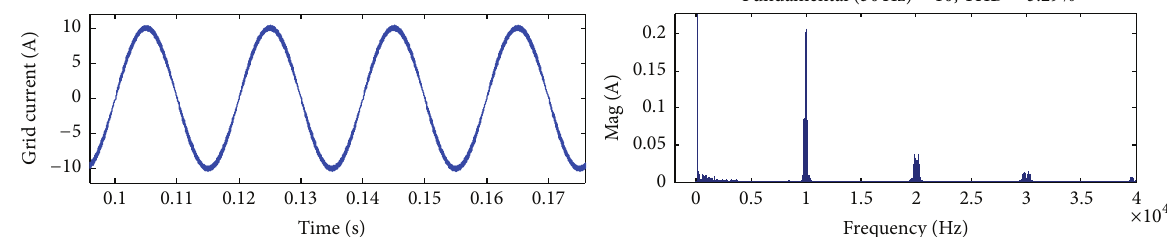
Figure 6: Simulation results of output waveforms in the time and frequency domains.